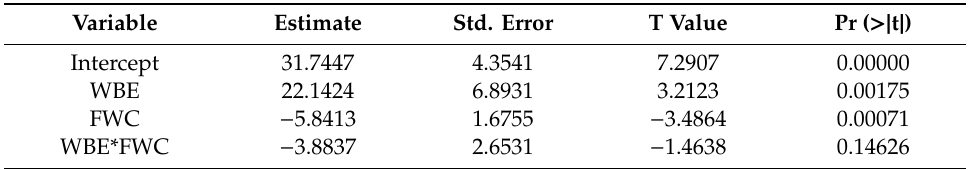
Table 12. Statistical analysis of the model predicting HL of 35 / 50 foamed bitumen based on the foaming water content, WBE content and their